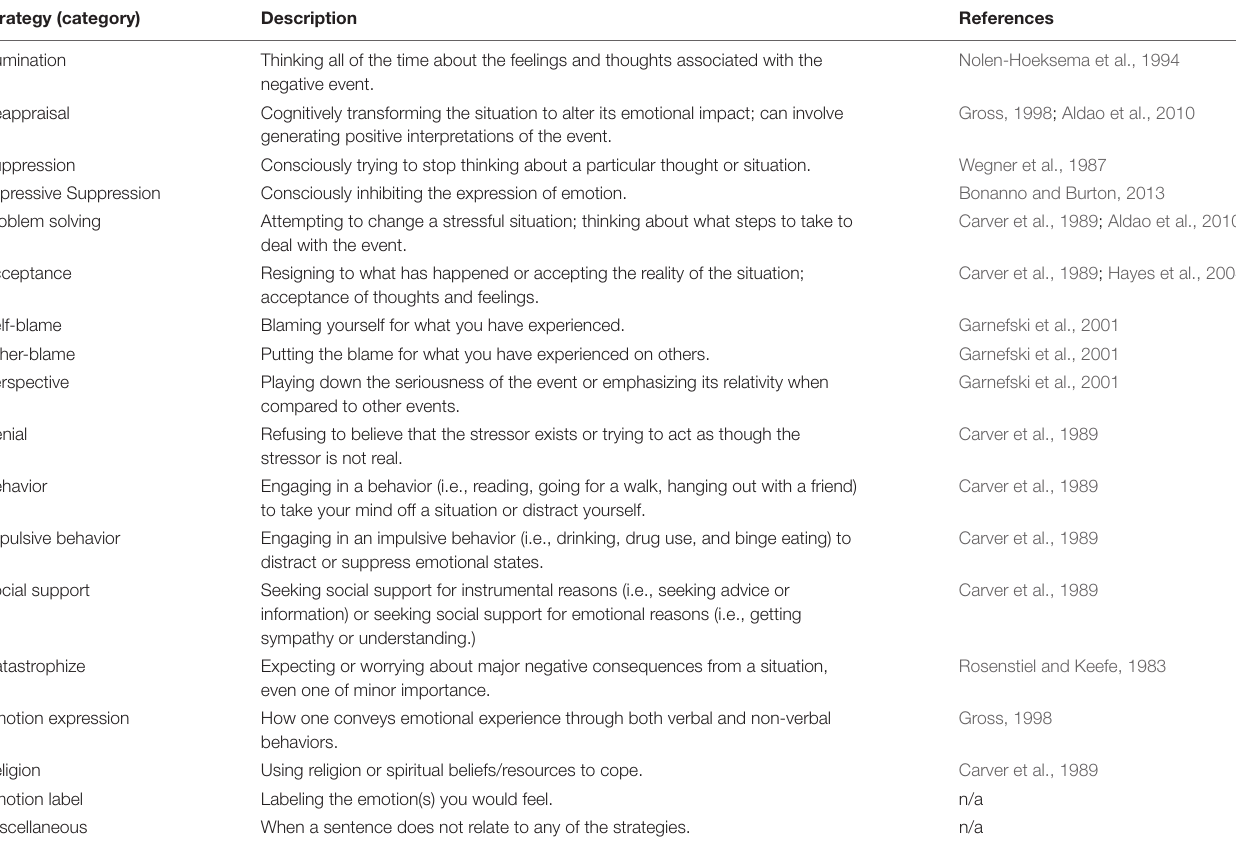
TABLE 1 | Summary of coding scheme: descriptions of